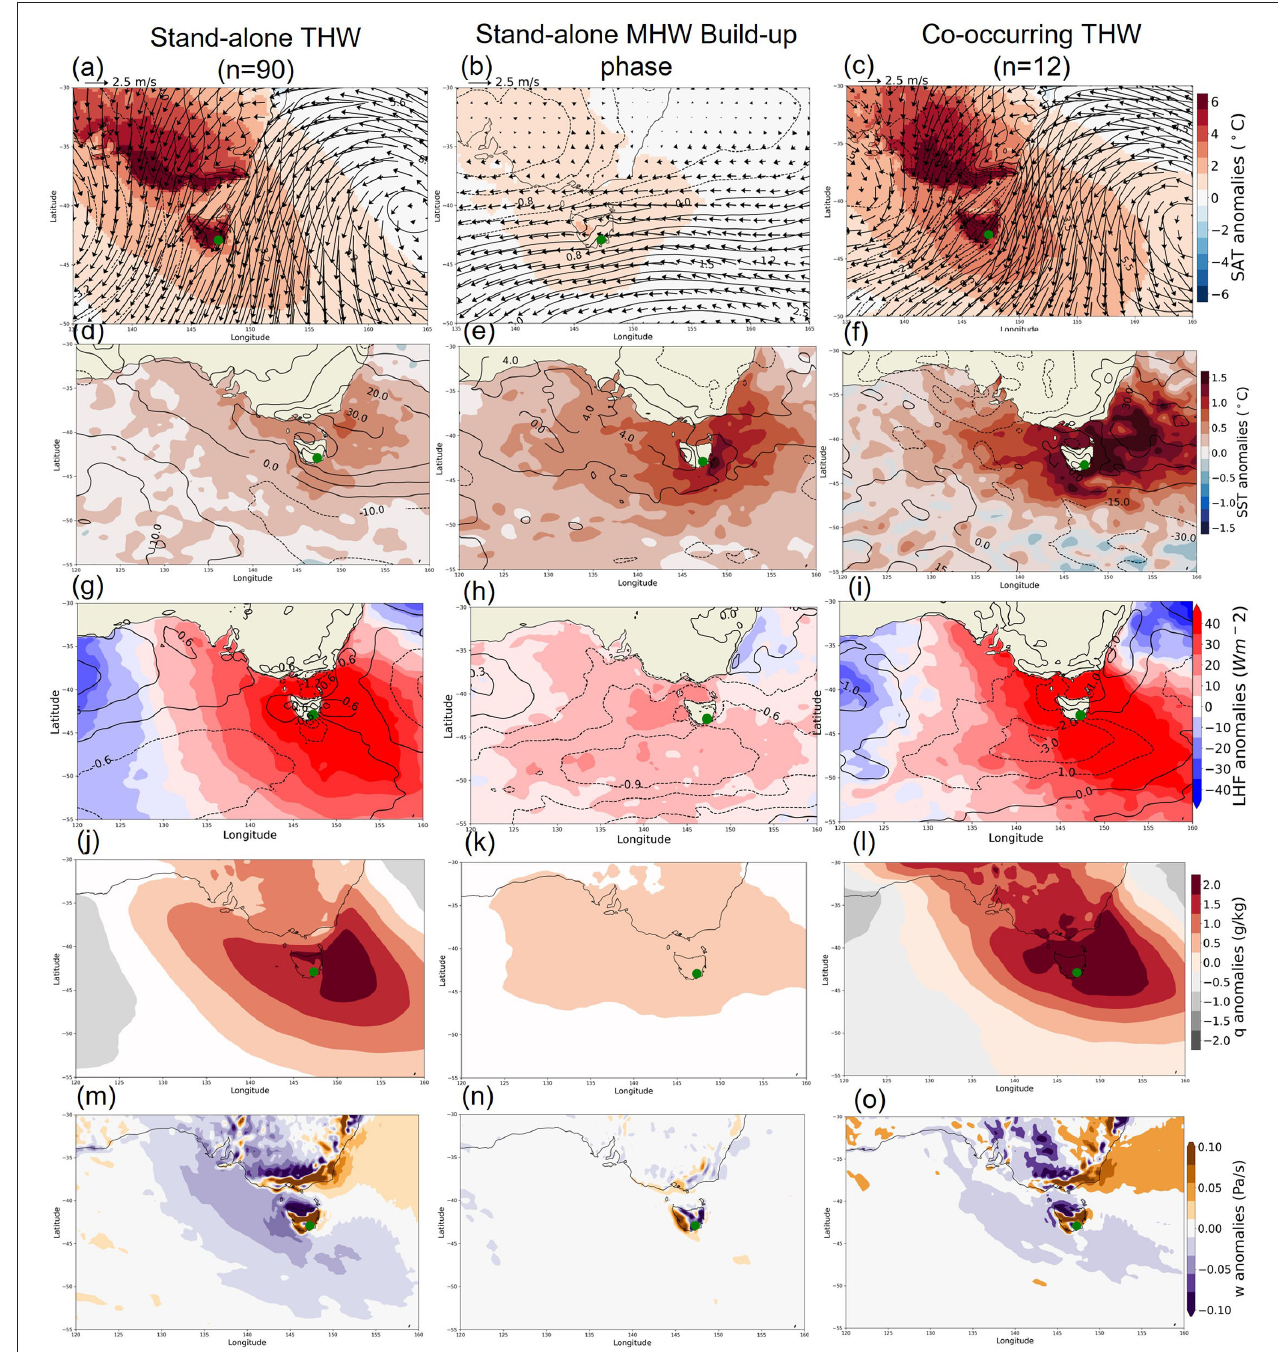
FIGURE 10 | Composite synoptic conditions for stand-alone THWs (left column), stand-alone MHW build-up (center) and co-occurring THW (right column) in Hobart. (a–c) show SAT anomalies (shaded), MSLP anomalies (line contours) and wind vectors. (d–f) show SST anomalies (shaded) and SWR anomalies (line contours). (g–i) show LHF anomalies (shaded) and windspeed anomalies (line contours). (j–l) show specific humidity anomalies. (m–o) show vertical velocity anomalies at 850 hPa. Negative LHF implies a flux of heat from the land/ocean surface to the